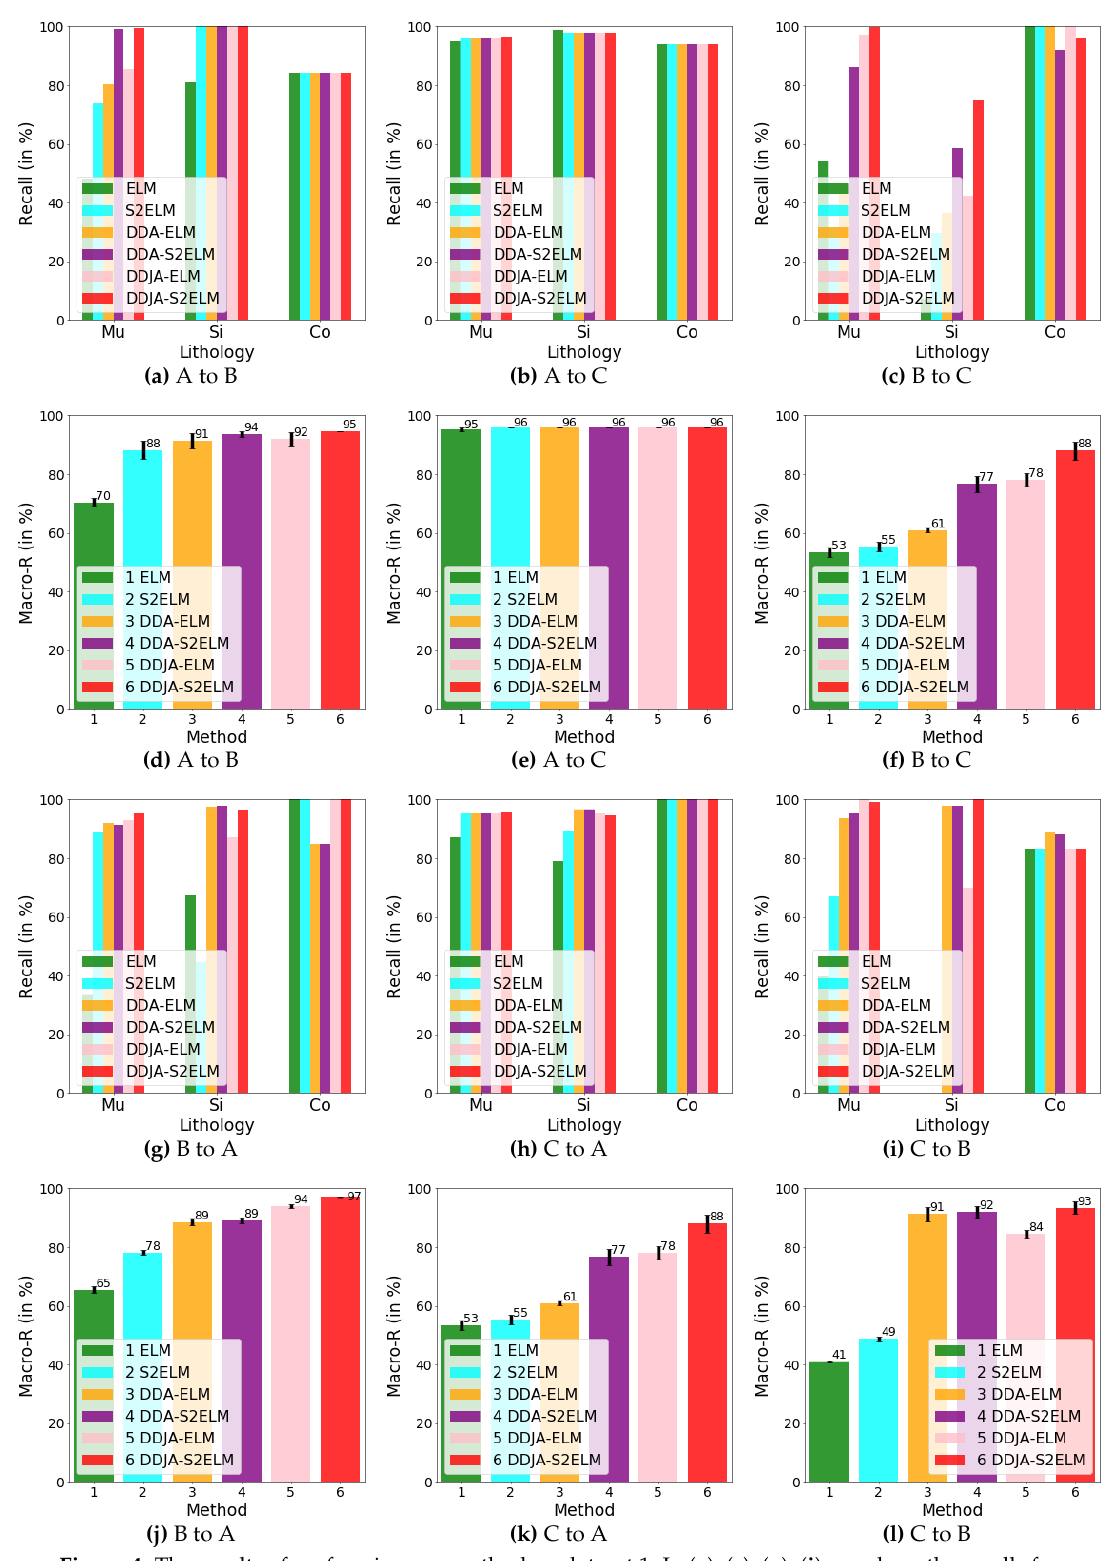
Figure 4. The results of performing our method on dataset 1. In ( a )–( c ), ( g )–( i ), we show the recalls for the classes of Mu, Si, and Co by using different methods. In ( d )–( f ), ( j )–( l ), we show the macro average recalls by using different